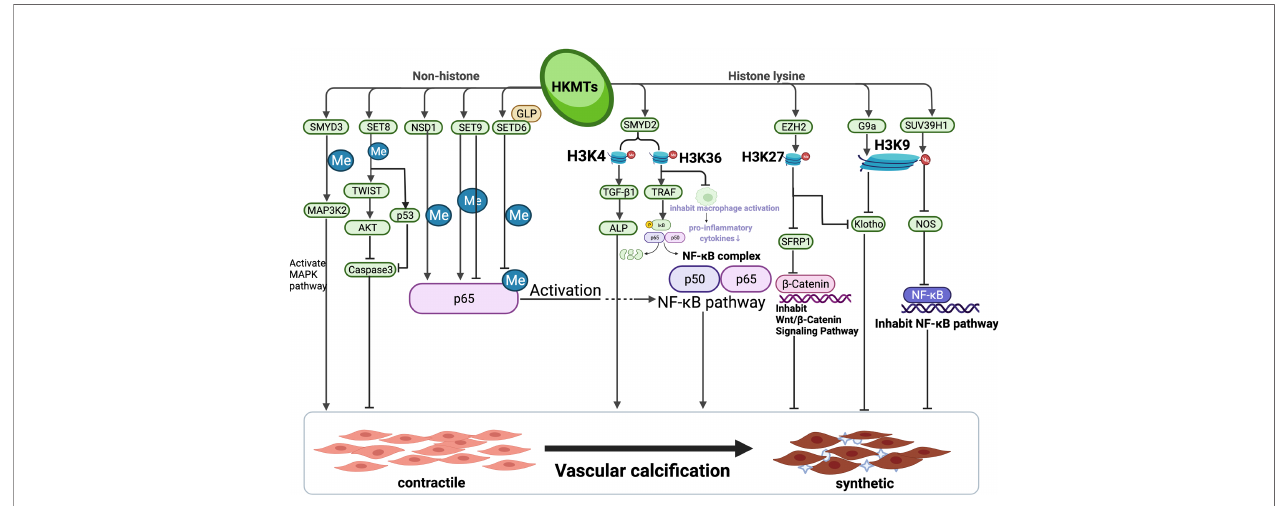
FIGURE 2 | Complex network of relevant pathways involving mutual interactions in vascular calci fi cation via HKMTs. The entire process of vascular calci fi cation is the consequence of a complex integrated effect which is determined by multiple pathways. HKMTs, as a post-translational modifying enzyme that can act on both histone lysine and catalyze lysine from non-histone, have been shown to perform a sophisticated function in inhibiting or promoting multiple pathways of VC progression. This fi gure summarizes the pathways constituted by the mechanisms involved in vascular calci fi cation by HKMTs and their role in the process of vascular calci fi cation. Created with